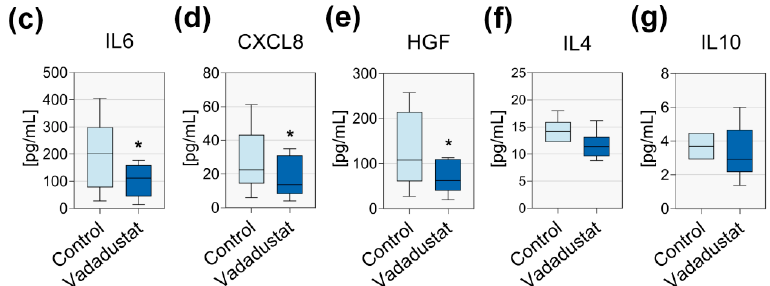
Figure 3. Analysis of the secretome from 6 populations of human bone marrow-derived mesenchymal stromal cells (hBM-MSCs) pretreated with Vadadustat for 24 h. ( a , b ) Proteome profiler analysis of cytokines and chemokines whose secretion by MSCs: ( a ) increased or ( b ) decreased by at least 20% as a result of 24 h pretreatment with 40 µ M Vadadustat. Bars represent IOD (integrated optical density) of antibodies-dots measured by chemiluminescent detection. The values above the bars show what percentage of control MSCs secretion (indicated as 100%) are values obtained after incubation with Vadadustat. Samples from 6 MSCs populations were pooled for the analysis. ( c – g ) Quantitative evaluation of ( c ) IL6, ( d ) CXCL8, ( e ) HGF, ( f ) IL4 and ( g ) IL10 level in the secretome of 6 BM-MSCs populations cultured under control conditions or preconditioned with Vadadustat, conducted using Luminex assay. The samples were not pooled for analysis. Boxes show quartiles of secreted cytokine amount in pg / mL with median, whiskers represent “min to max” values. * indicates the statistically significant di ff erence ( p < 0.05) by Wilcoxon matched-pairs signed-rank test in the groups of related data with abnormal distribution, and by Student’s t-test in the groups of related data with confirmed normal